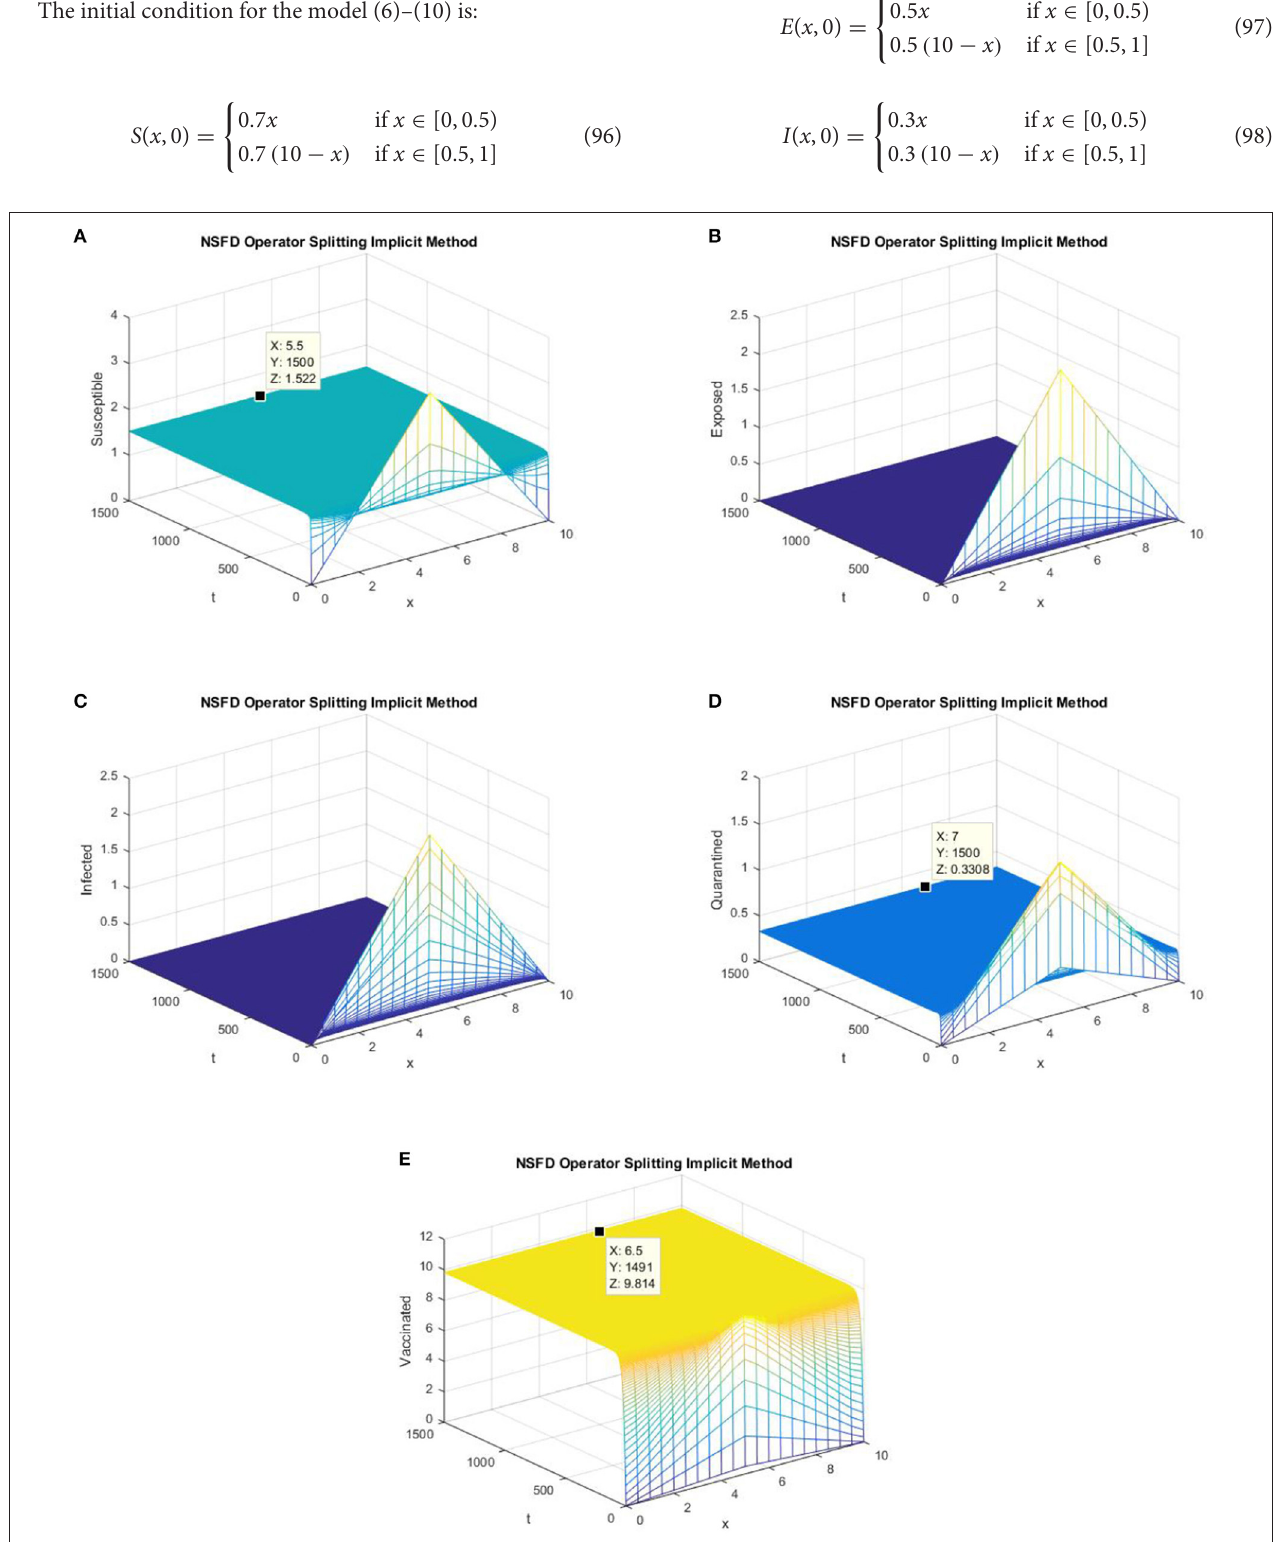
FIGURE 2 | The implicit operator splitting NSFD scheme is used to simulate graphs (A–E) . (A) Mesh graph of S ; (B) Mesh graph of E ; (C) Mesh graph of I ; (D) Mesh graph of Q ; (E) Mesh graph of V .